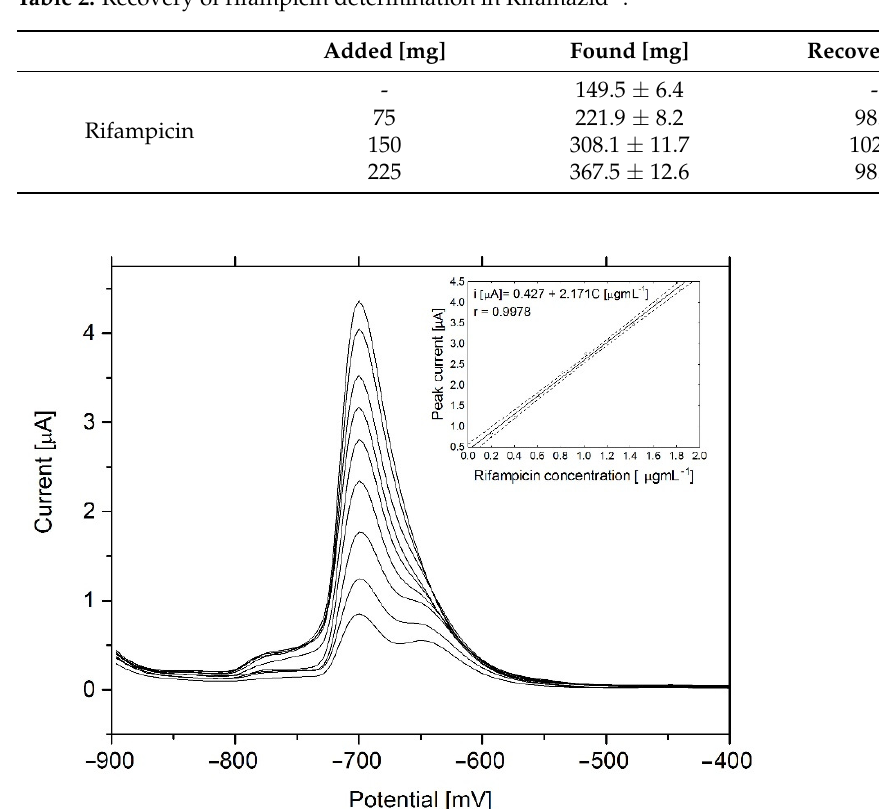
Figure 7. Linearity range of voltammetric determination of rifampicin 0.2–1.8 µgmL − 1 . The electrode area was 9.7 mm 2 . Instrumental parameters: ∆ E = 30 mV, E s = 4 mV, tw, tp = 10 ms. Stirring rate, 500 rpm. Table 3. Rifampicin determination in pharmaceuticals formulation.